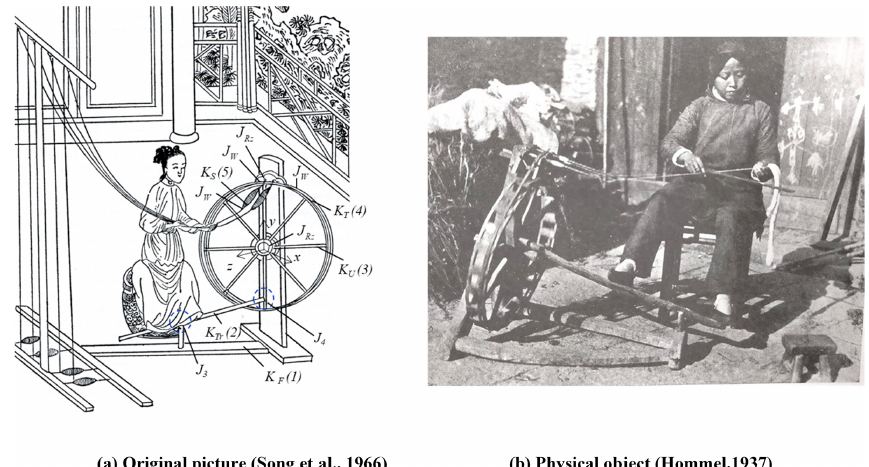
Figure 6. Treadle spinning